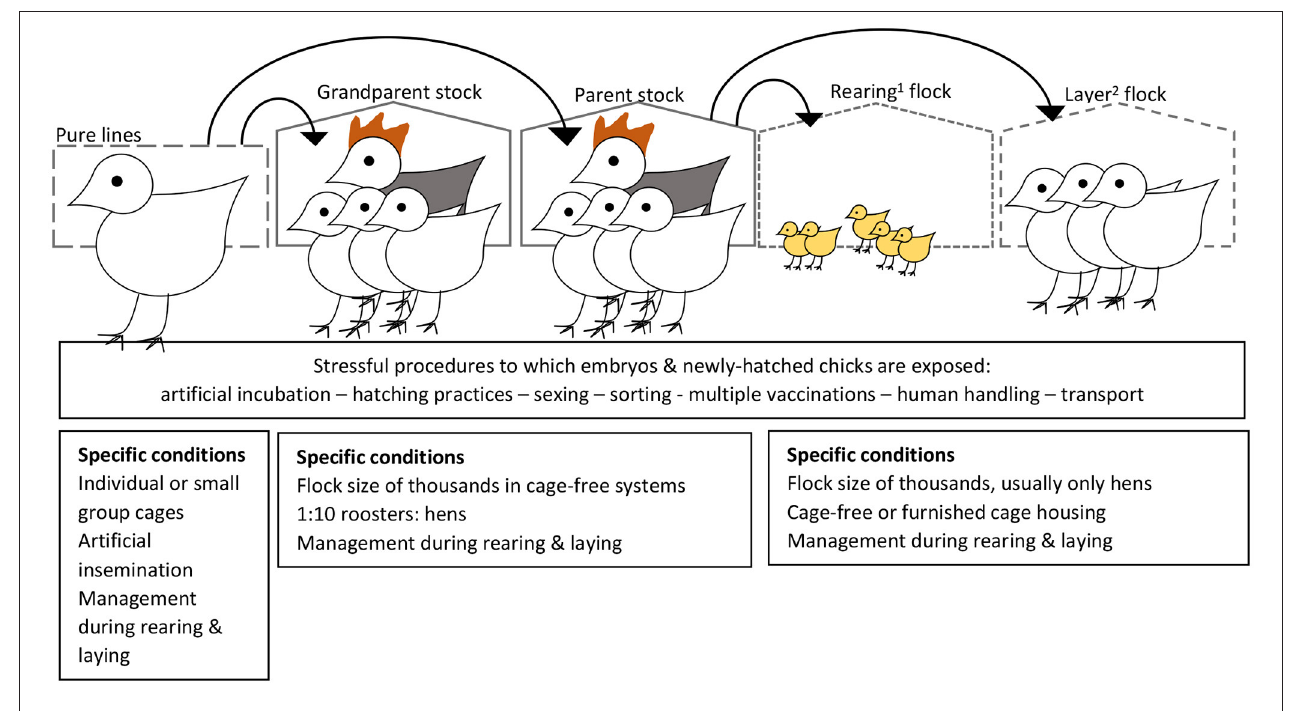
FIGURE 3 | Set-up of the commercial egg-industry, and sources of variation in environmental conditions within and across generations that could lead to differential embryonic programming of behavioural phenotypes and subsequent risk for development of injurious pecking behaviour. 1 Rearing of pullets occurs from arrival from the hatchery (referred to as 1 day of age) until ∼ 17–18 weeks of age. 2 The point-of-lay hens are then transported to the laying house (typically at a different farm), where they are kept until the egg production rate and egg quality drop toward economically non-viable levels (typically 80–100 weeks of age). Although egg farmers would prefer pullets reared in a similar housing type (e.g., aviary vs. cage) with similar equipment set-up (e.g., feeder, drinker and perch types, and locations) to that at the laying farm, some variation is almost inevitable. Management of the rearing and laying flocks needs to coordinated (e.g., similar dietary ingredients and lighting schedule at the point of transition to the laying house) for a smooth, relatively low-stress transition. Risk factors for development of injurious pecking have separate as well as interacting effects across the rearing and laying phases (7, 8, 14,